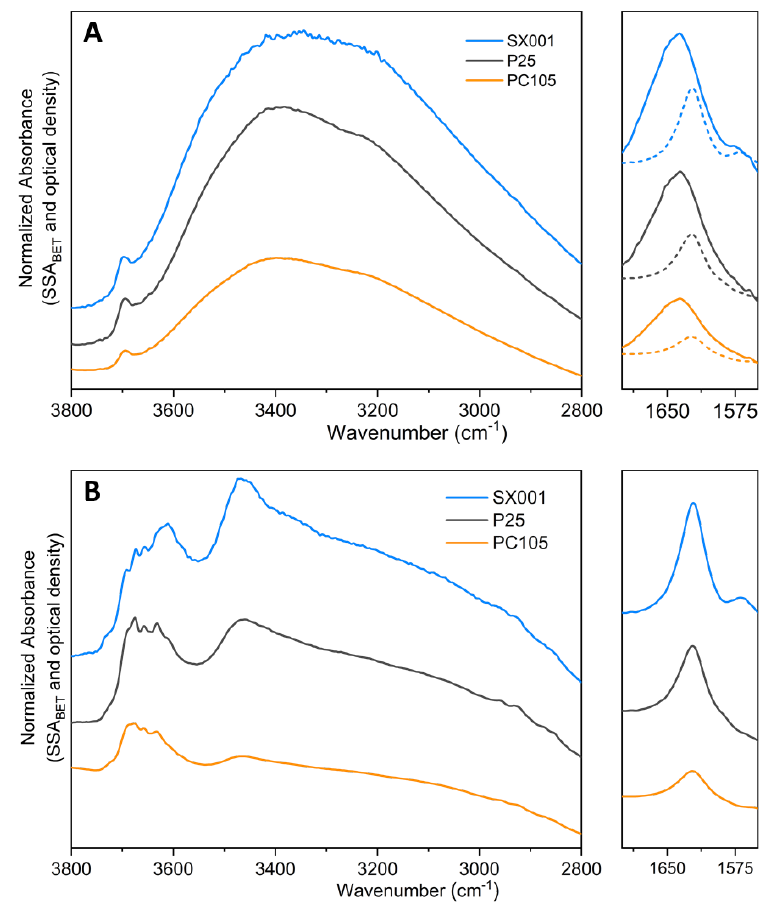
Figure 5. MIR spectra of SX001 (light blue), P25 (dark grey) and PC105 (orange), previously activated at 873 K, in contact with H 2 O at 15 mbar (part A ) and after outgassing H 2 O for 15 min at beam temperature (part B ). To facilitate the comparison, the spectra after outgassing for 15 min are also reported in part ( A ), as dashed curves, in the H 2 O bending region. All the spectra have been normalized by dividing the absorbance by the specific surface area (m 2 / g) and the “optical thickness” (g / m 2 ) of the pelletized samples.